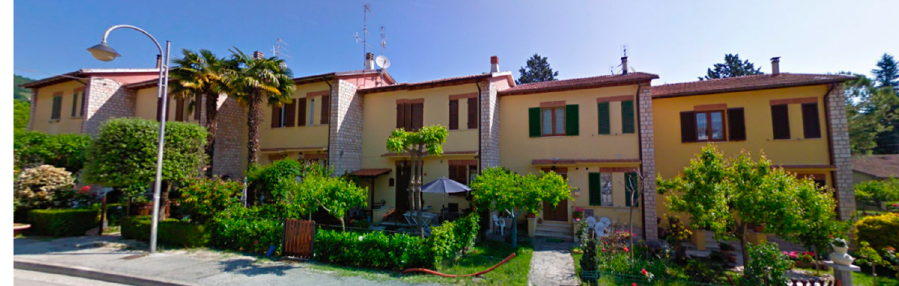
Figure 3. External view of IACP building before earthquake (adapted from Google Earth).